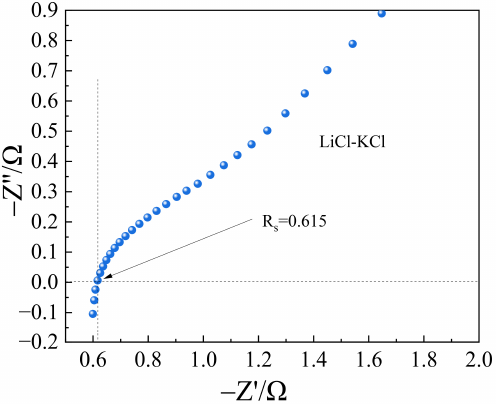
Figure 1. EIS data on the W electrode in molten LiCl-KCl at temperatures of 773 K.